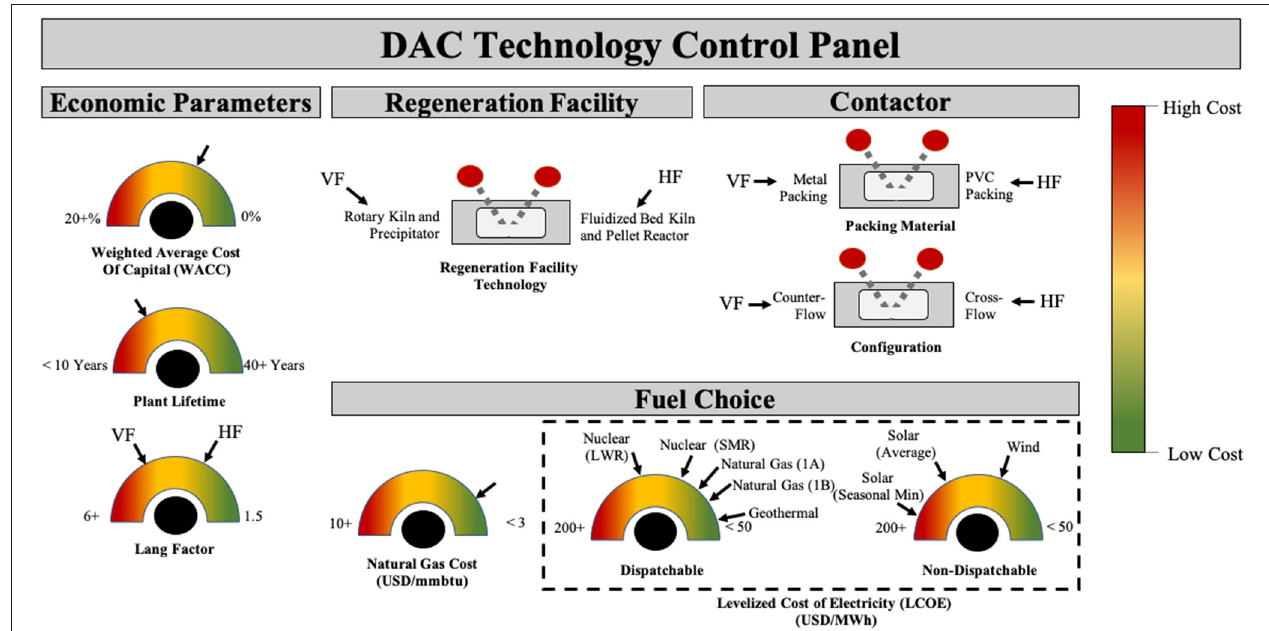
FIGURE 8 | Direct air capture control panel, with three switches and six dials that summarize the options considered in this paper. The arrows on the dials show values used in the analysis of specific cases. For the three dials where there is just one arrow, the value is used for all cases and is examined in a sensitivity analysis.